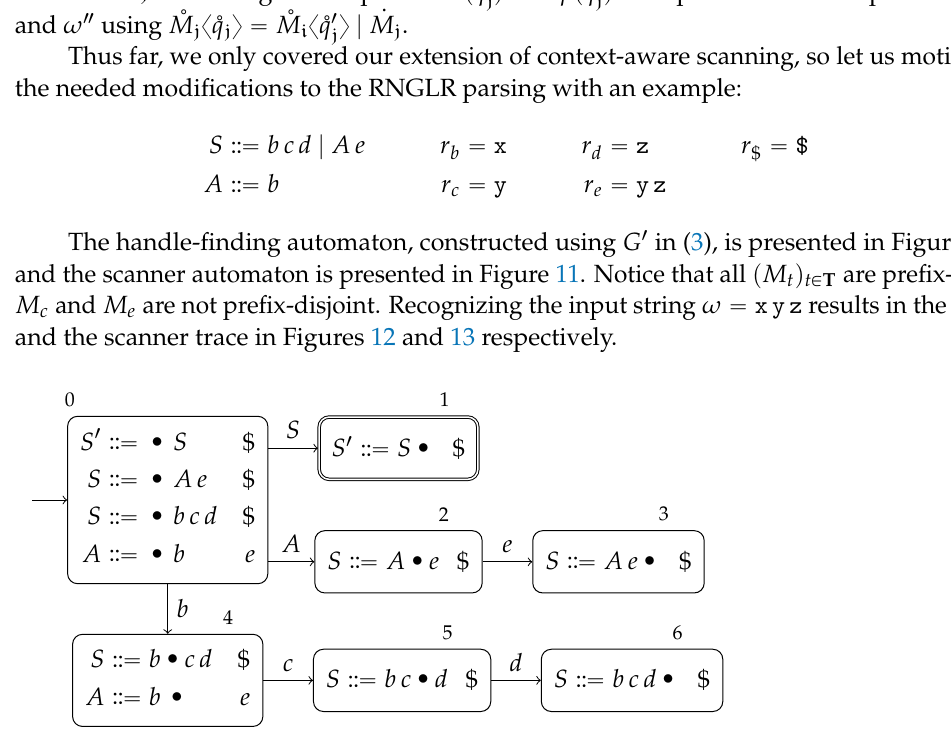
Figure 10. The handle-finding automaton for the specification Ξ in (3), constructed using G 1